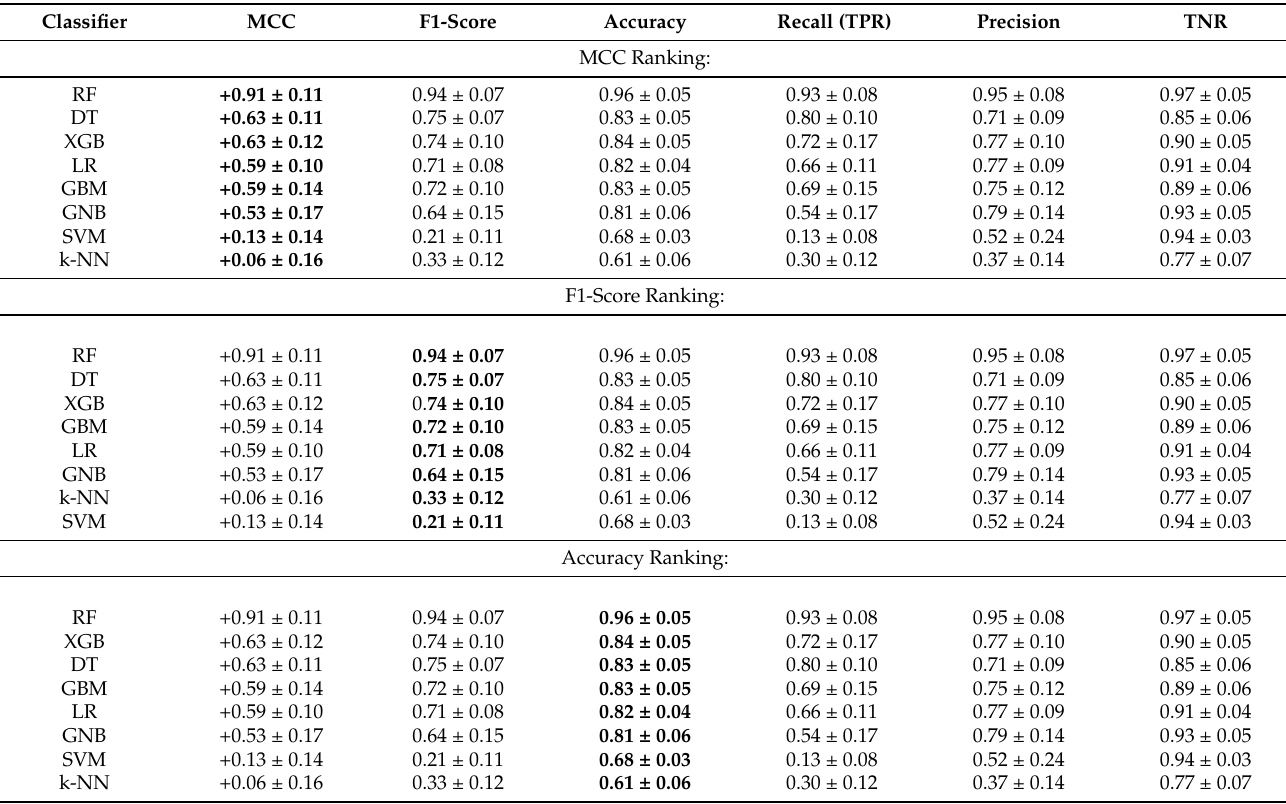
Table 17. Survival-Status Classification Performance